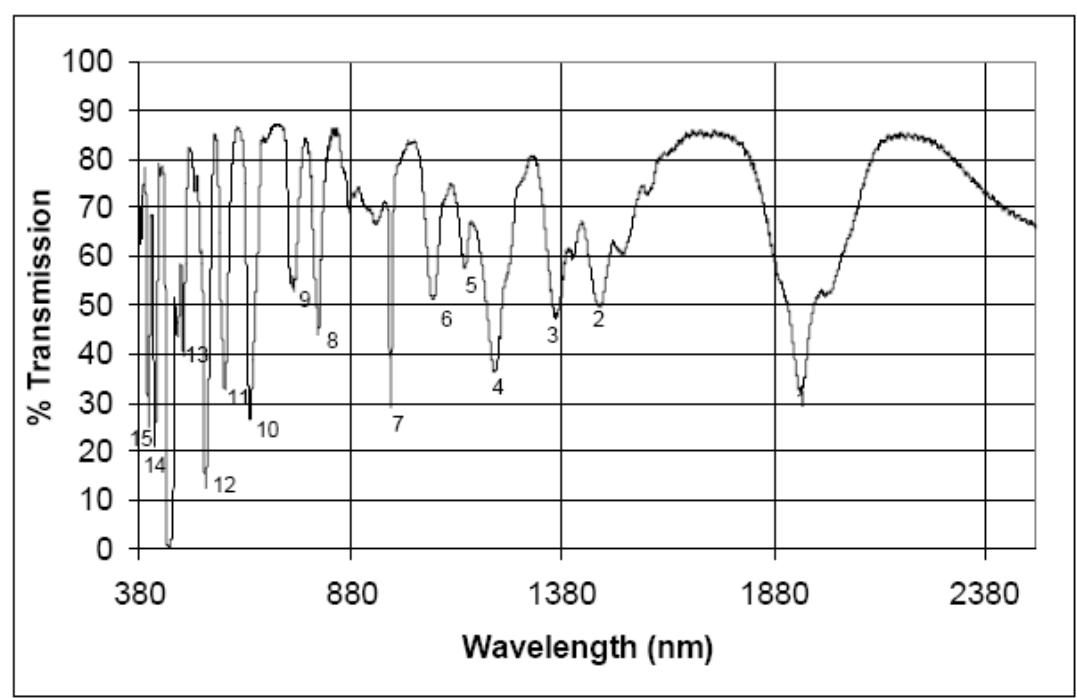
Figure 7. Spectral features of the NIST rare earth filter SRM (Standard Reference Materials) 2085 used in the IFC spectral calibration. Numbers 1 to 15 denote the spectral absorption